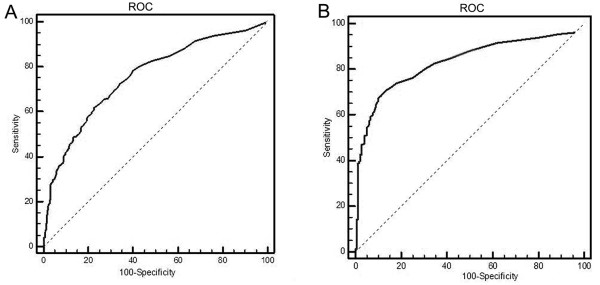
Receiver operating characteristic curve for the procalcitonin diagnosis of simple infection and infection complicated by congestive heart failure. (A) Diagnostic curve of procalcitonin (PCT) for simple bacterial infections. The area under the receiver operating characteristic curve shown is above 80%, which means PCT still has the diagnostic value for simple bacterial infection and infection complicated by congestive heart failure. (B) Diagnostic curve of PCT for infection complicated by congestive heart failure. ROC, Receiver operating characteristic curve. The dashed line is the baseline that result from random classification.